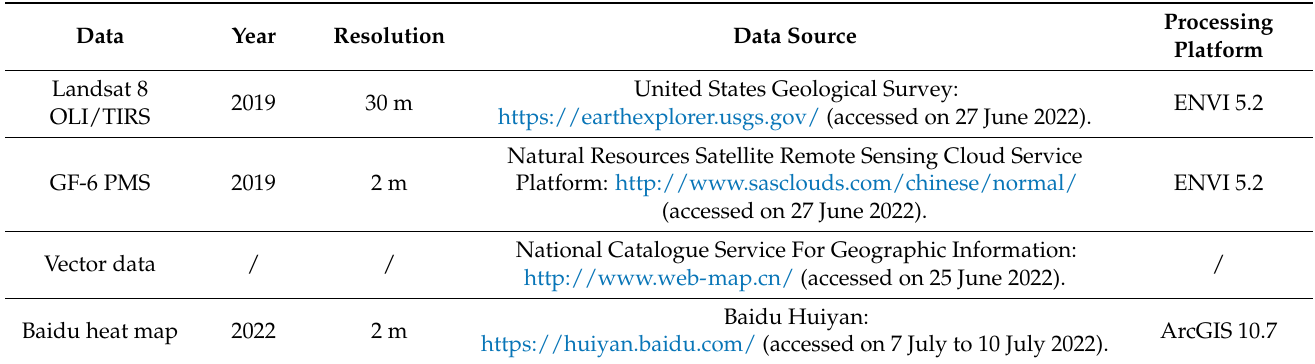
Table 1. Data sources and processing